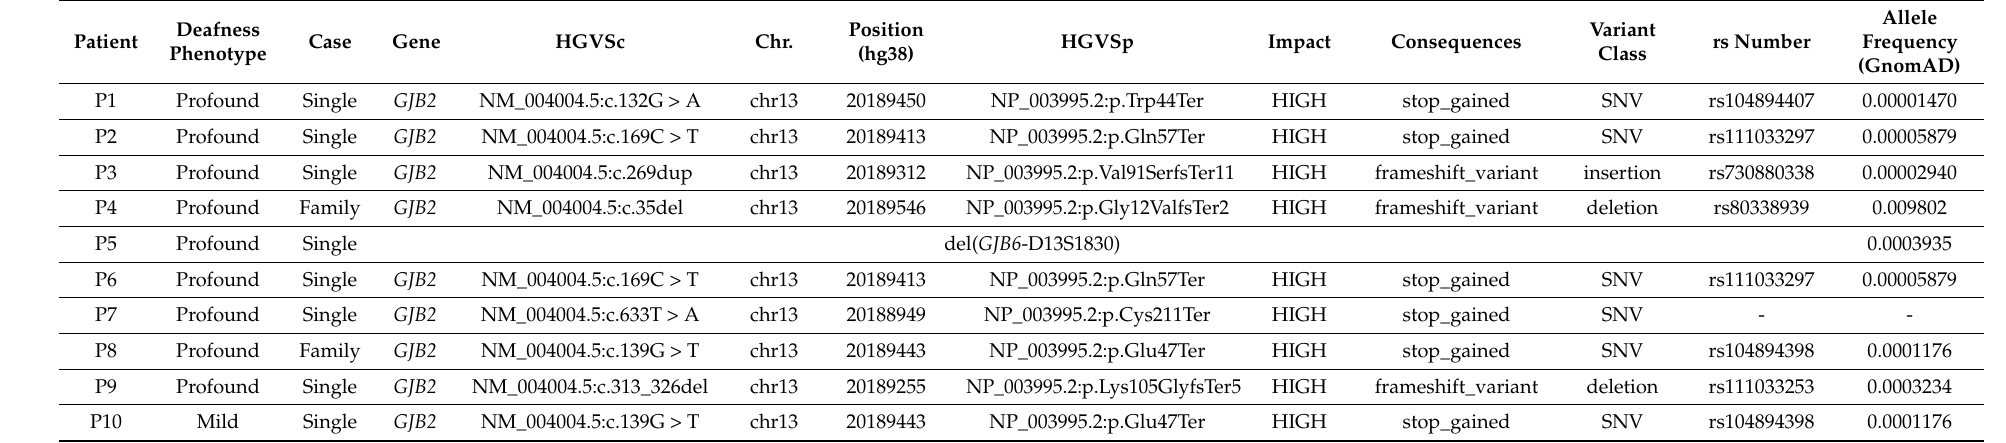
Table 1. Patient genotypes (monoallelic) at the DFNB1 locus before WGS.